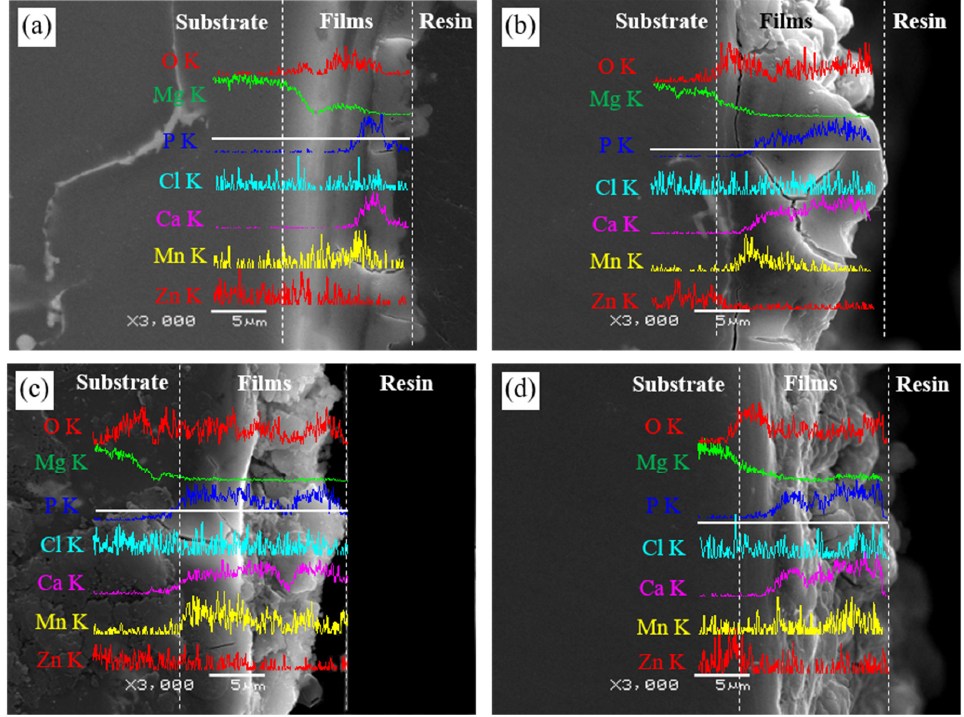
Figure 8. The cross-sectional view of the 12 h sample immersed in SBF solution: ( a ) 24 h, ( b ) 72 h, ( c ) 120 h, ( d ) 168 h, white lines correspond to the EDS-scanned area. Figure 9 depicts the corrosion protection mechanism model of the